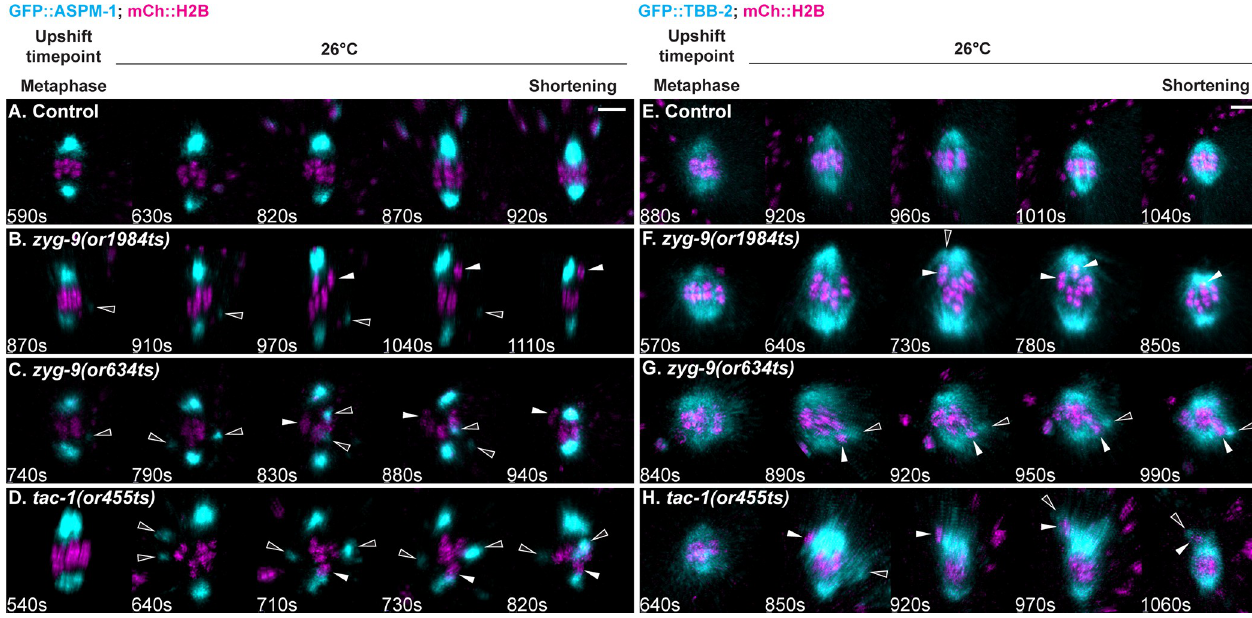
Fig 6. Ectopic poles are associated with chromosome congression defects in zyg-9 and tac-1 TS mutant oocytes. (A-H) Imaris rotated and snapshot projected time-lapse images (see Materials and Methods) of live control and TS mutant oocytes upshifted at metaphase expressing GFP::ASPM-1 and mCherry::H2B (A-D) or GFP::TBB-2 and mCherry::H2B (E-H). Montage frames highlight defects following metaphase upshift through to spindle shortening. Hollow arrowheads indicate ectopic spindle poles; solid arrowheads indicate chromosome congression errors. Montages of oocytes in A, C, D, F, G, and H are the same oocytes shown in Fig 5 montages A, C, D, I, J, and K, respectively. Scale bars = 5 μ